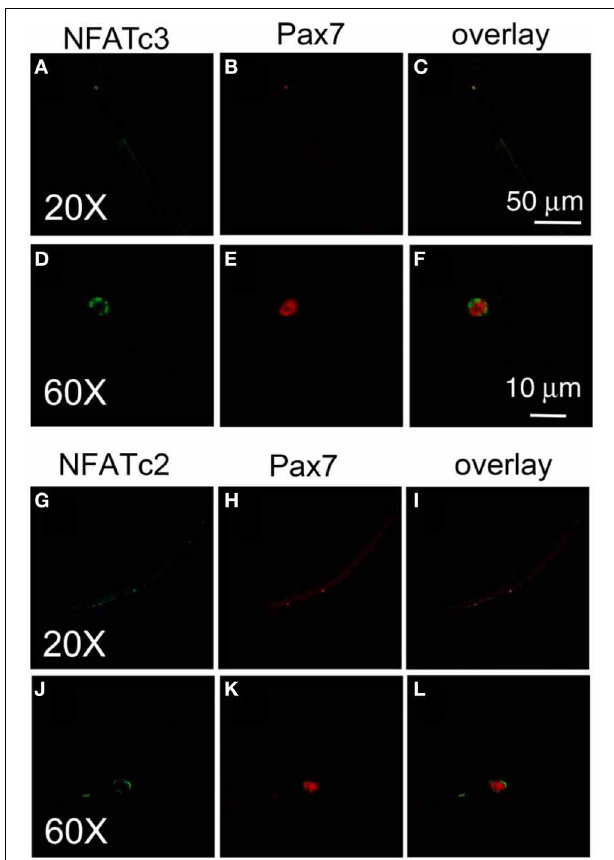
FIGURE 6 | Both NFATc3 and NFATc2 are expressed in satellite cells. Freshly isolated FDB fibers and associated satellite cells were fixed and immunostained with anti-NFATc3 and anti-Pax7, or with anti-NFATc2 and anti-Pax7. NFATc3 is expressed in satellite cells, with much higher staining levels than in the adult host FDB fibers (A,D) . Detailed analysis shows that NFATc3 localizes in the cytoplasm not in the nucleus in the non-activated satellite cells in contrast to Pax7 (B,E) . NFATc2 is expressed in satellite cells, localized at cytoplasm (G,J) in contrast to Pax7 which is in the nucleus (H,K) . (D–F) are the same cell as (A–C) but at higher magnification. (J–L) are the same cell as (G–I) but with higher